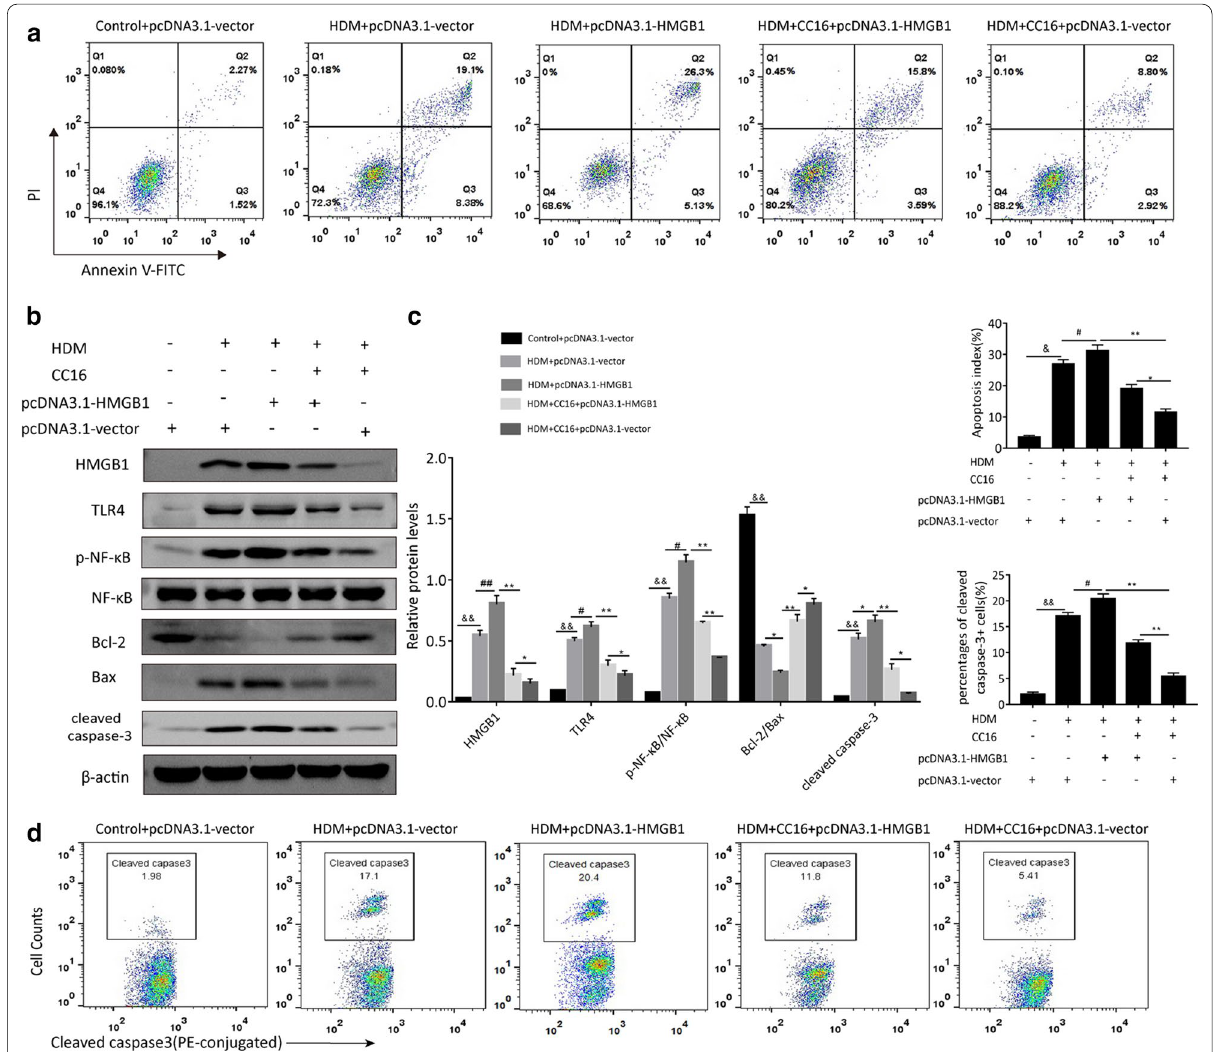
Fig. 8 CC16 modulates airway epithelial cell apoptosis in response to HDM through the inhibition of HMGB1-mediated signaling. BEAS-2B cells were transfected with pcDNA3.1-HMGB1 plasmid or pcDNA3.1-vector, and then treated with HDM or CC16 or HDM a Flow cytometry analysis of HDM-induced apoptosis in BEAS-2B cells. b Western Blotting analysis of HMGB1, TLR4, NF-κB, p-NF-κB, Bcl-2, Bax in BEAS-2B cells under different experiments. c Quantification of the indicated proteins normalized to GAPDH were shown as bar graphs. d Flow cytometry detection of caspase-3 activation in BEAS-2B cells. &p < 0.05 vs. PBS group; # p < 0.05 vs.